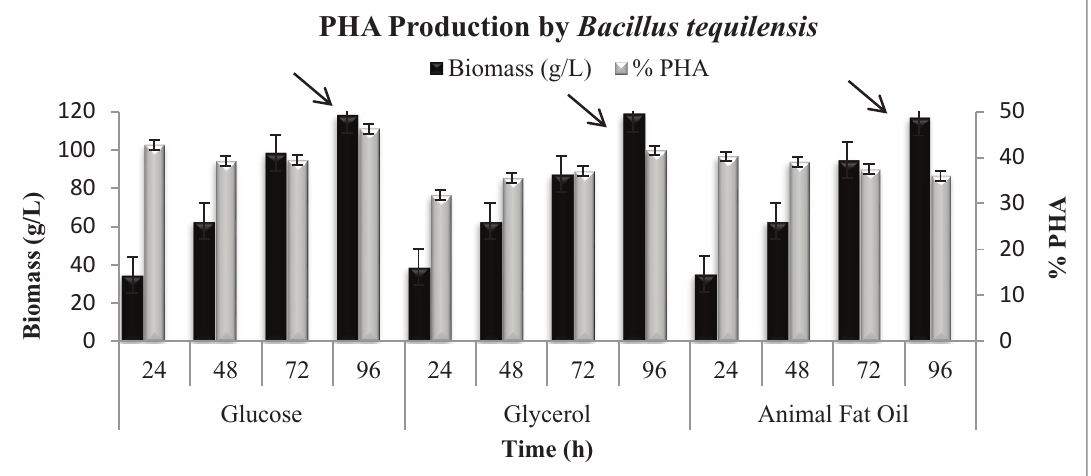
Figure 3: PHA production by strain PWF ( Bacillus tequilensis ; MH142145). PHA production by strain PWF ( Bacillus tequilensis ; MH142145) was highest, after 96 h on glycerol and after 24 h on animal fat oil. Biomasses and percentage PHA plotted against time are the mean of values recorded, during triplicate experiment. Standard error was